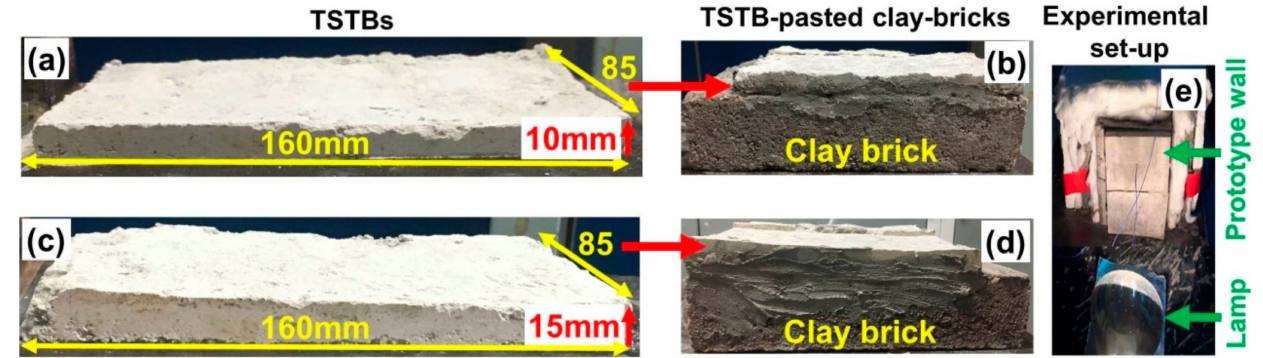
Figure 4. ( a ) TSTB10, ( b ) TSTB10-pasted clay-brick, ( c ) TSTB15, ( d ) TSTB15-pasted clay-brick, and ( e ) Prototype wall and experimental setup for thermal